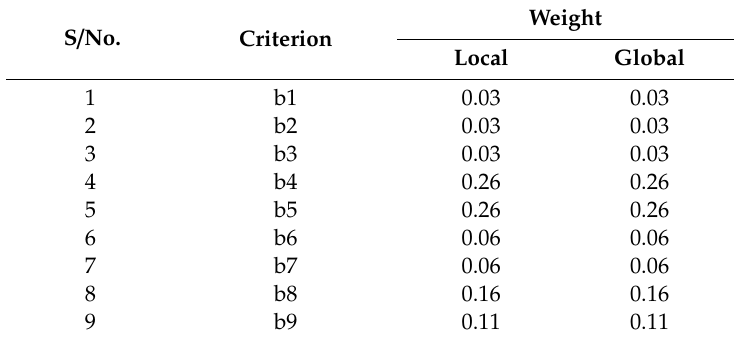
Table A3. Criteria weights by aggregate of all evaluators for organization barriers. S / No.